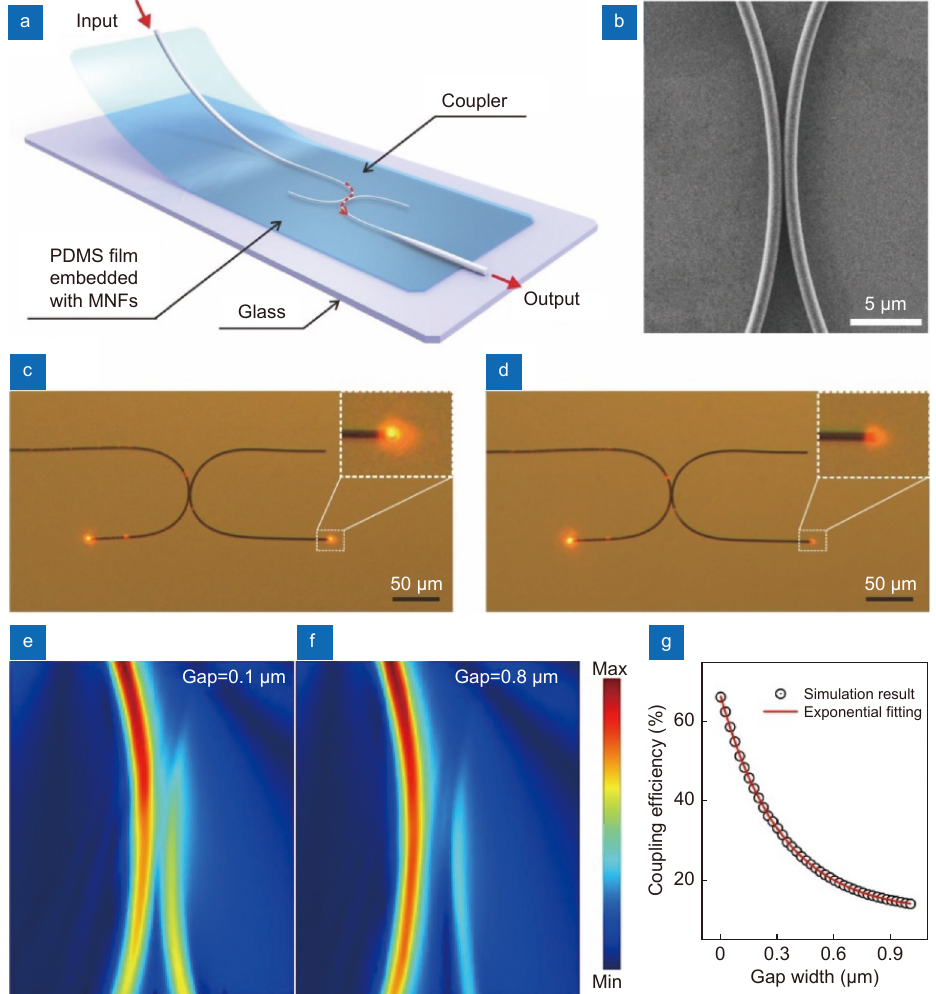
Fig. 1 | Working principle of the strain sensor based on MNF coupler. ( a ) Schematic diagram of a strain sensor structure. ( b ) SEM image of the coupling region in a typical MNF coupler. ( c , d ) Optical micrographs of an MNF coupler before and after slightly changing of the gap, respect- ively. The wavelength of input light is 660 nm. ( e , f ) The simulated electromagnetic field intensity distributions of MNF coupling structures with gap widths of 0.1 μm and 0.8 μm, respectively. The diameter of each MNF is 0.9 μm and the bending radius is 50 μm. The refractive index of sur- rounding material is set as 1.40. ( g ) The coupling efficiency as a function of gap width of coupled